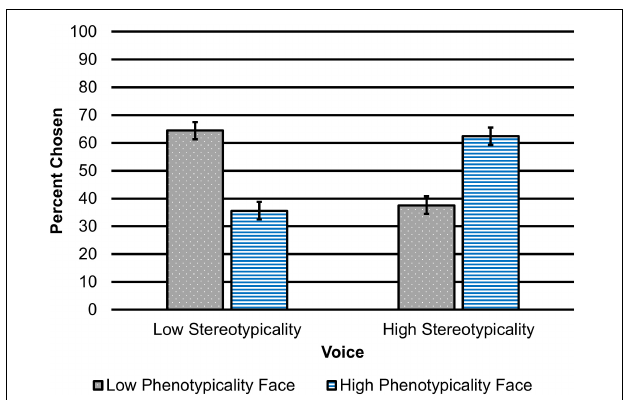
FIGURE 1 | Percent of low and high phenotypicality face selections after listening to low and high stereotypicality speakers. Error bars represent 95% confidence